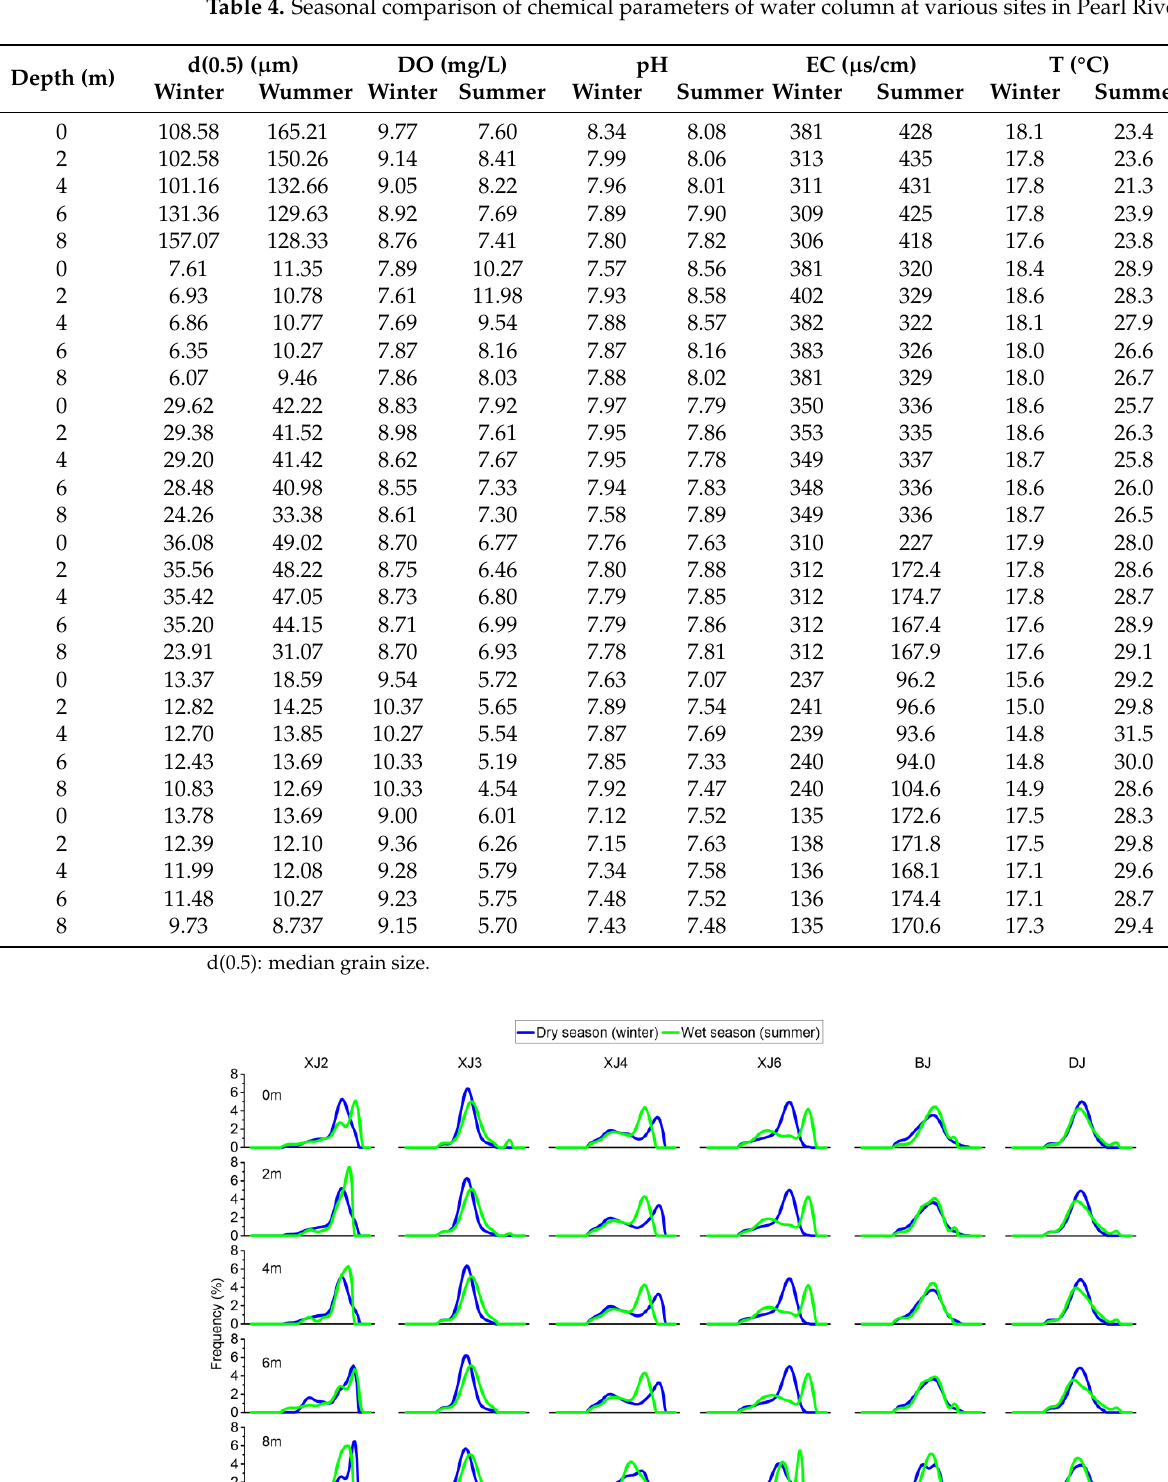
Table 4. Seasonal comparison of chemical parameters of water column at various sites in Pearl River.